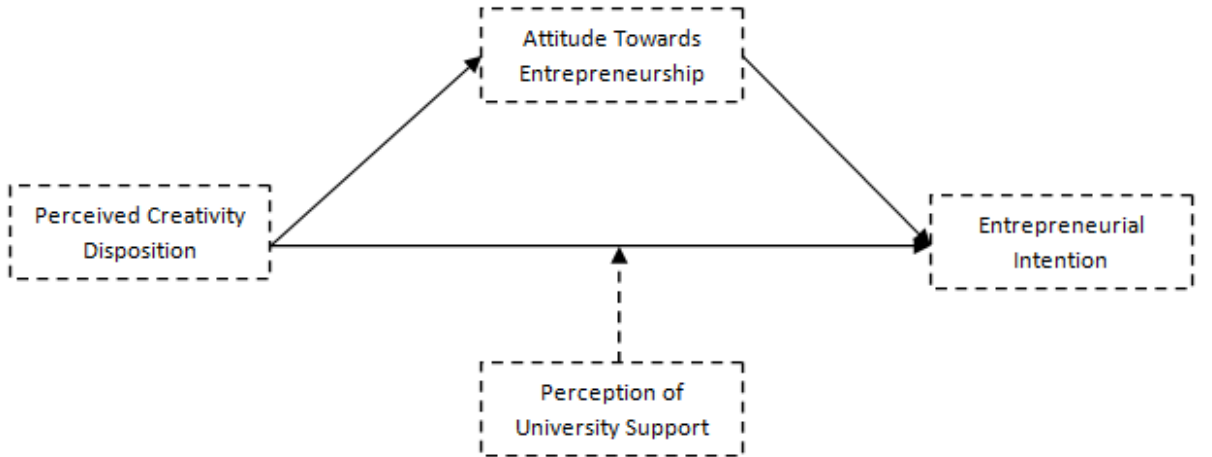
Figure 1. Conceptual framework.